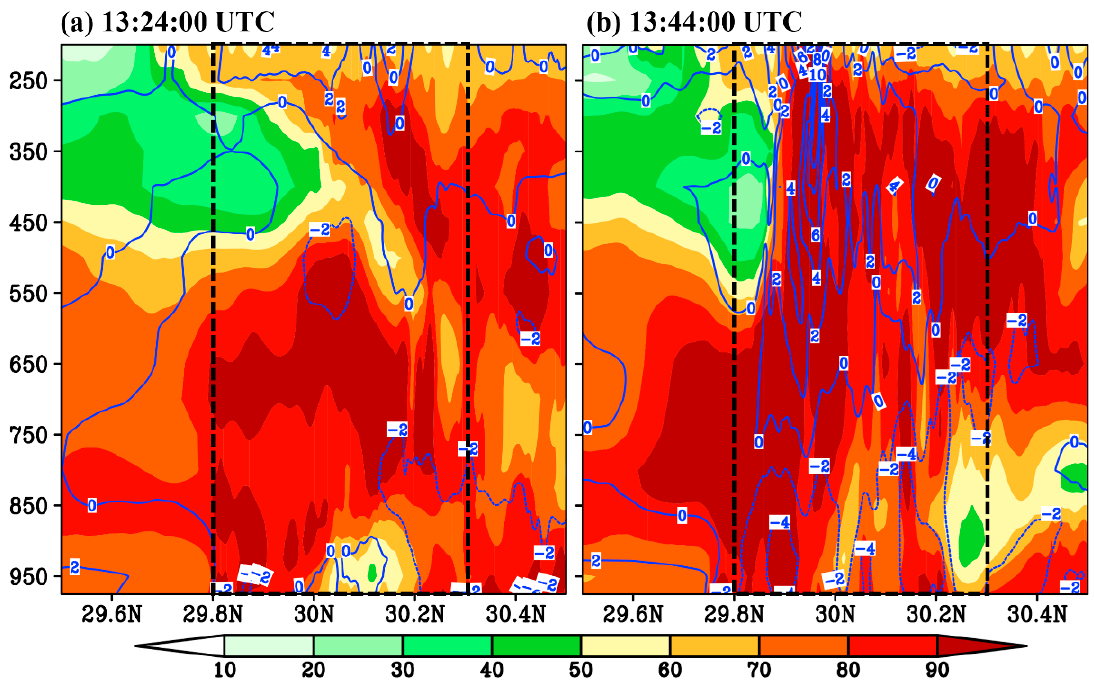
Figure 12. Panels ( a , b ) show the averaged (from 120.24° E to 120.32° E) cross section of the relative humidity (shading; %) and temperature deviation (blue contour; °C) at typical stages, where the black dashed lines mark the key region. The ordinate is pressure and the abscissa is latitude.